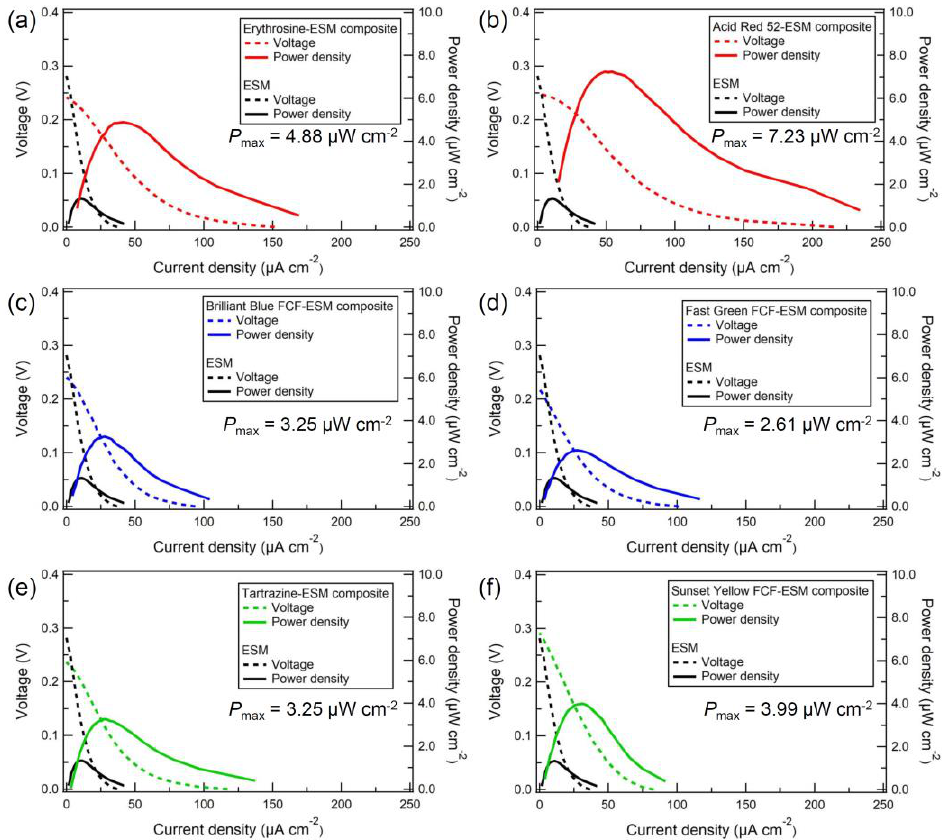
Figure 5. The I – V curves of dye-ESM composites. Xanthene-type (red): erythrosine ( a ) and Acid Red 52 ( b ); triphenyl-type (blue): Brilliant Blue FCF ( c ) and Fast Green FCF ( d ); azo-type (green): Tartrazine ( e ) and Sunset Yellow FCF ( f ).